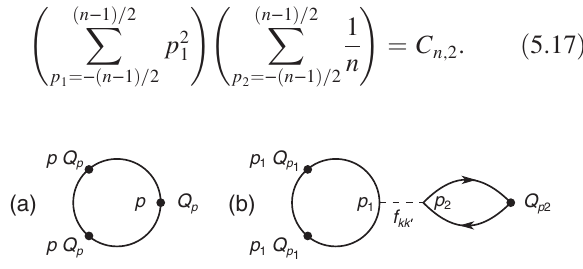
FIG. 10. Feynman diagrams for calculating S Q in the replica A;n analysis, focusing on the h Q 3 term which contributes to the i c A logarithmic divergence in I Q 3 . While the noninteracting diagram in (a) contributes a quantized logarithmic divergence in I Q 3 , Fermi liquid interaction gives rise to additional diagrams, such as (b), which modify the coefficient of